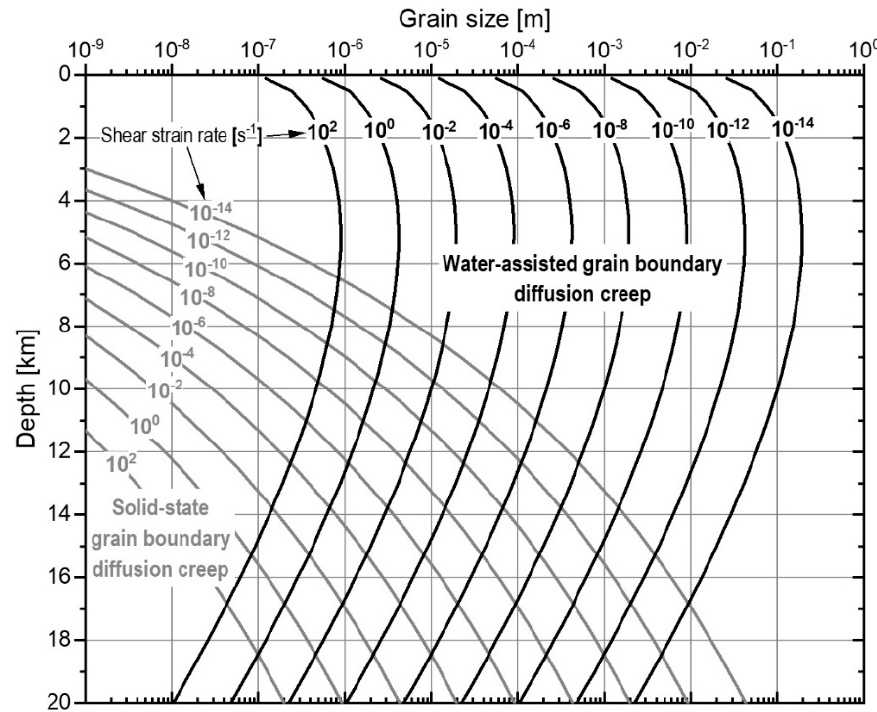
Figure 8. Water-assisted and solid-state grain boundary diffusion creep in calcite (Equation (1)), plotted as grain size vs. depth (taking 30 °C/km and a density of 2700 kg m − 3 ). For a list of parameters used see Table 3.